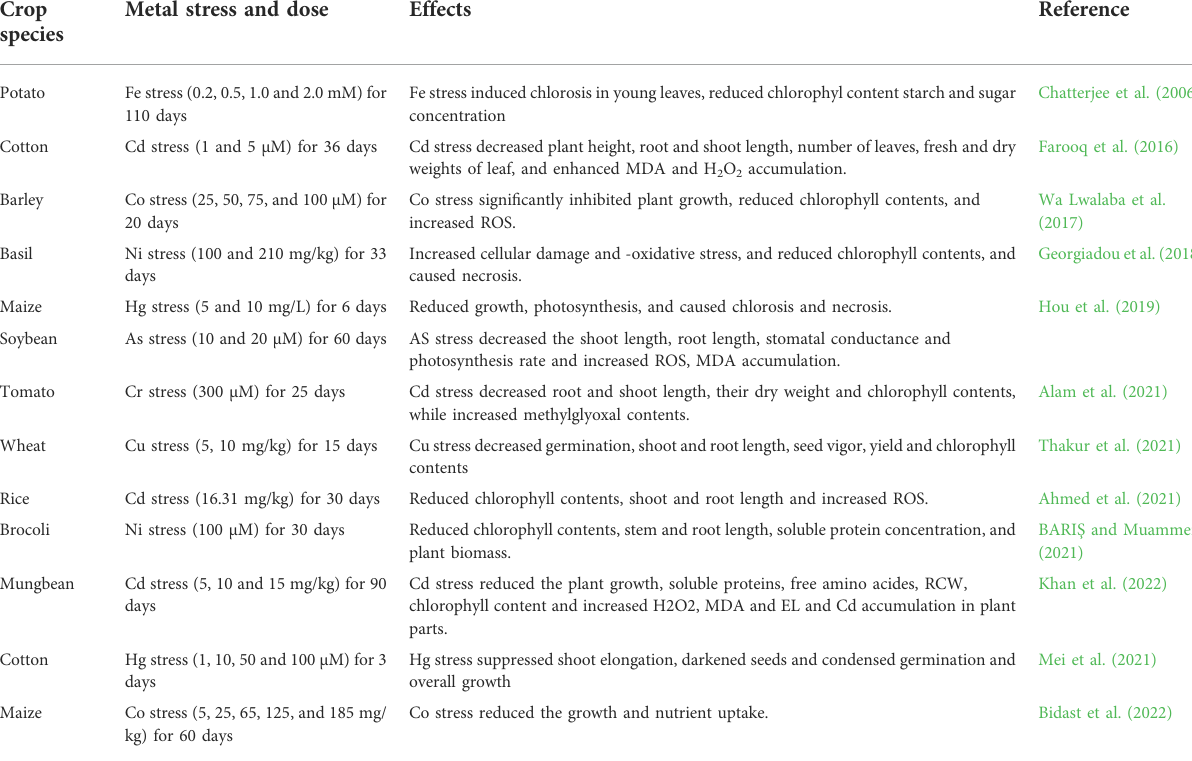
TABLE 1 Effect of different heavy metals on growth and physio-biochemical process of various crops Crop